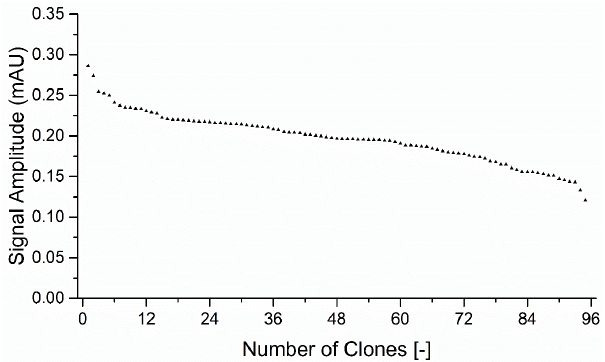
Figure A4. Standard deviation of the CE with P450 BM3 WT. Detected signal amplitude (mAU) at λ 214 nm in descending order of P450 BM3 variant WT catalyzed conversion of benzo-1,4-dioxane in a 96-well plate. The standard deviation (15.6%) is depicted with white triangles.